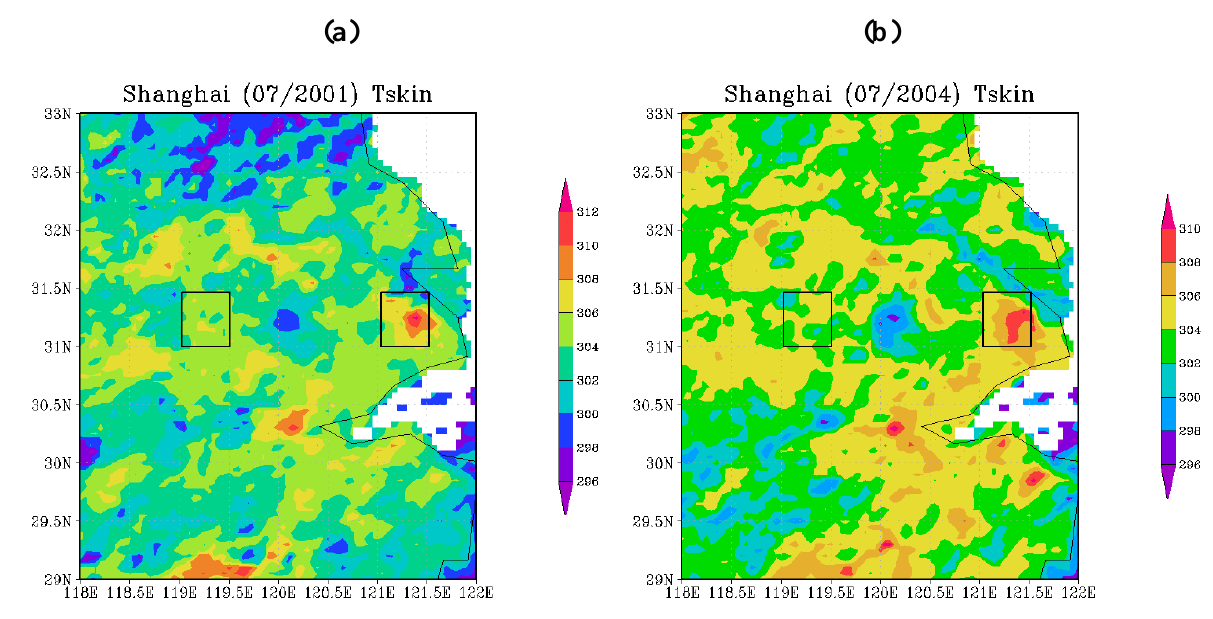
Figure 4. Monthly mean T in July for (a) 2001 and (b) 2004 with Shanghai (right box) skin and rural (left box). The T data is obtained from Terra MODIS at 10:30 skin